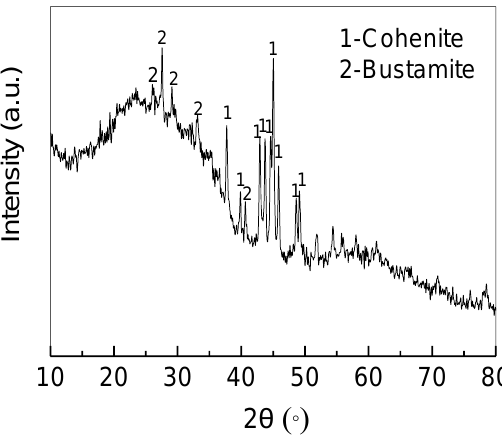
Table 2. Chemical composition of prepared FeSO 4 ·7H 2 O crystals.